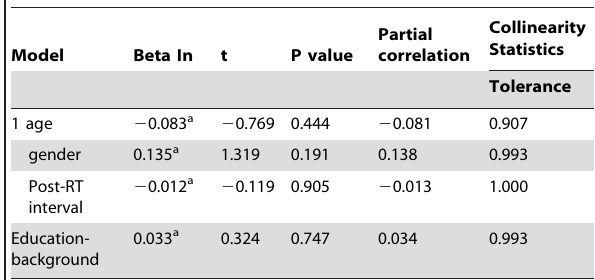
Table 6. Excluded variables b .